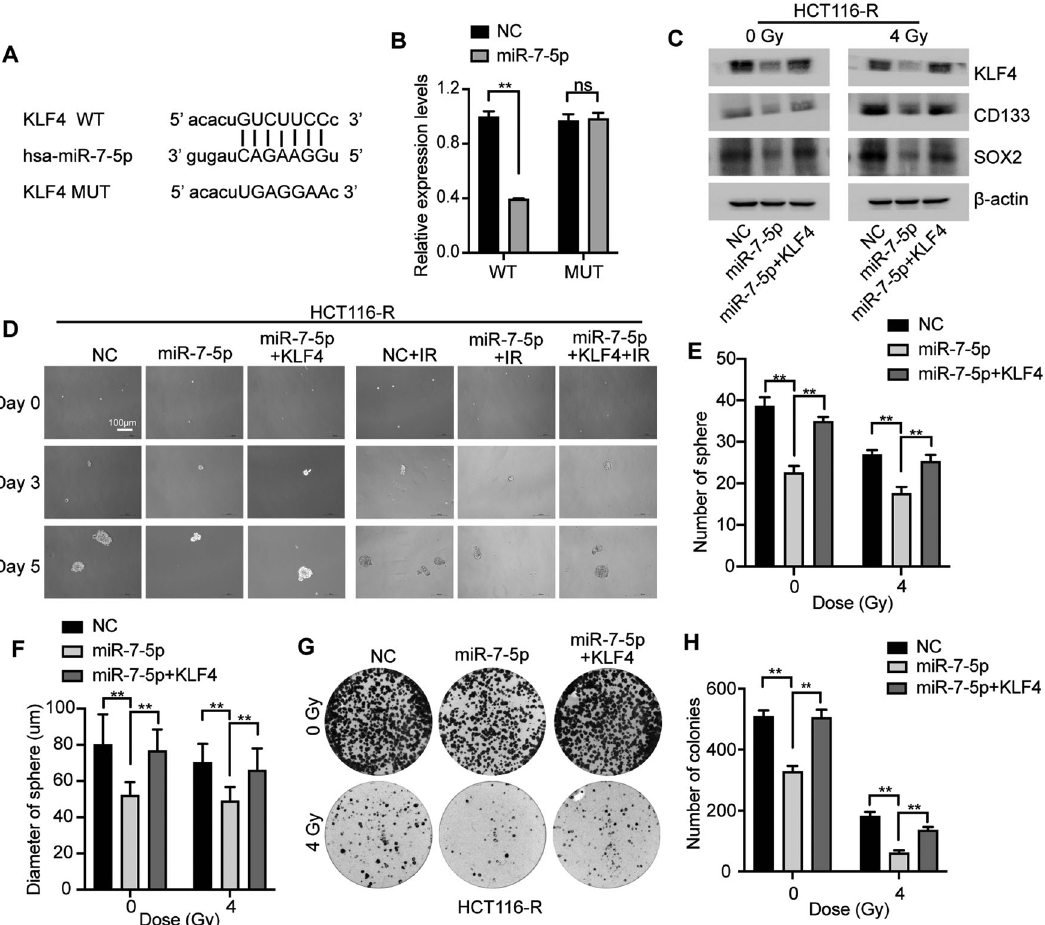
transfecting either WT or MUT pGL3-reporter luciferase vector with miR-7-5p mimics (miR-7-5p) or negative control (NC). C Adding back of KLF4 rescued the miR-7-5p-suppressed stem gene expression including CD133 and SOX2 in HCT116-R cells w/wo 4 Gy irradiation treatment. D Sphere formation assays using HCT116-R cells after transfection with miR-7-5p mimics w/wo KLF4 under 0 or 4 Gy irradiation. E, F Quantitative analysis of D revealed that adding back of KLF4 rescued the miR-7-5p-suppressed sphere formation. G Colony formation assays of HCT116-R cells after transfection with miR-7-5p mimics w/wo KLF4 under 0 or 4 Gy irradiation treatment. H Quantitative analysis of G demonstrated that adding back of KLF4 rescued the miR-7-5p-suppressed colony formation ability under irradiation of 0 or 4 Gy. Data are presented as mean ± SD; w/wo, with or without; IR, irradiation (4 Gy); ns, no signi fi cant difference; ** P <